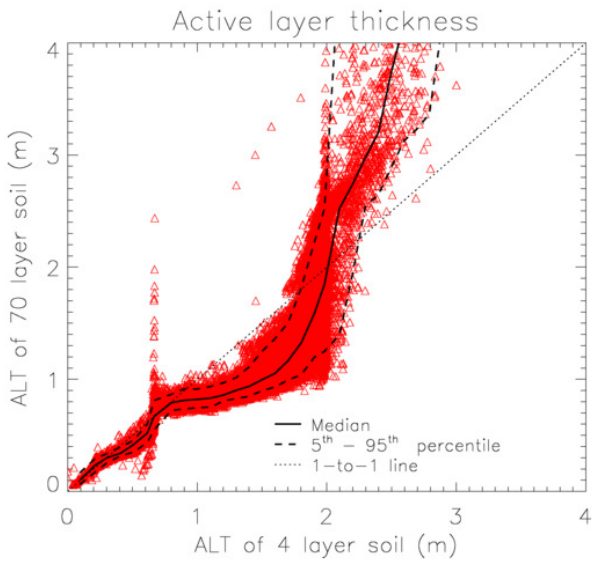
Figure 1. The correction factor applied to the HadGEM2-ES output to reduce the bias in the estimation of the active layer thickness.